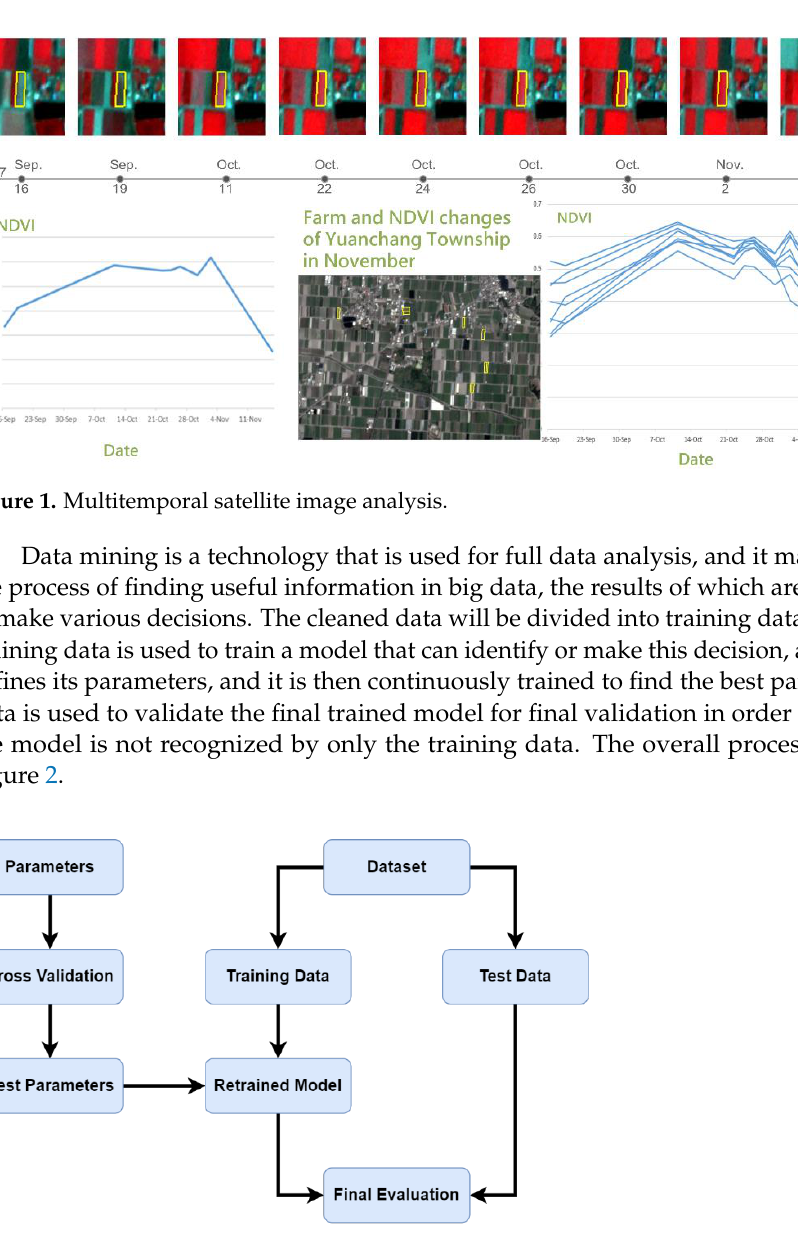
Figure 2. Data mining procedure.